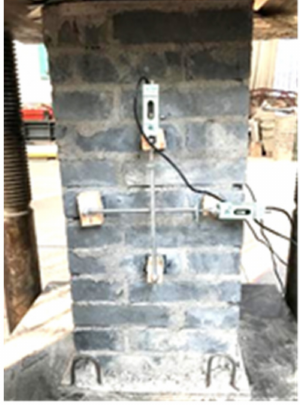
Figure 2. Sensors on the specimen.